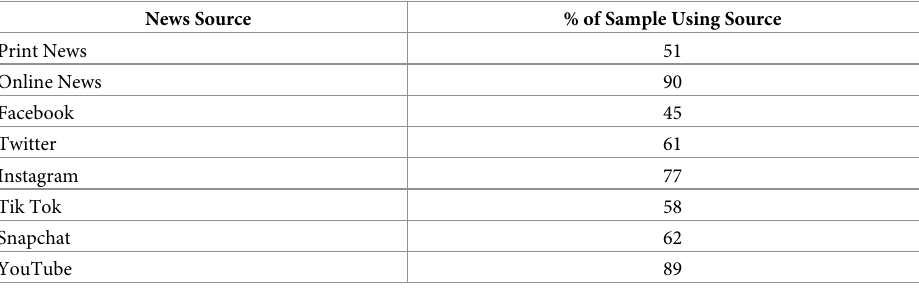
Table 2. Percentage of adolescents use of news